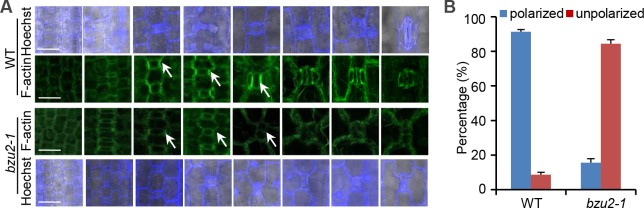
BZU2 is required for the polarization of subsidiary mother cells.(A) Confocal images of Hoechst 33258-stained (blue, top and bottom panel rows) and F-actin enrichment (green, two panel rows in the middle) in wild-type and bzu2-1 mutants at the base of the second and third leaves. In wild-type leaves, F-actin enrichment is observed at the SMC/GMC interface (arrowheads, second panel), and the SMC nuclei migrate towards the contact surface. In bzu2-1 mutants, there is no observable enrichment of F-actin patches at the SMCs/GMCs contact surfaces (arrowheads, third panel), and SMC nuclei fail to polarize. In the wild-type, the SMCs nuclei (blue) migrate to the GMCs (first panel), and in bzu2-1 mutants, most of the migration of the SMC nuclei (blue) vanishes (fourth panel). Scale bars, 25 μm. (B) Quantitative analysis of SMCs polarization in wild-type (127 SMC nuclei) and bzu2-1 mutants (167 SMC nuclei) at the base of the second and third leaves, for three independent experiments. In the wild-type, 91.3% of the 127 SMC nuclei that were examined migrate to the SMC/GMC contact surface (polarized). In contrast, 84.4% of the corresponding nuclei examined in bzu2-1 mutants remained unpolarized. Error bars indicate SD, **P<0.01, Student’s t test.